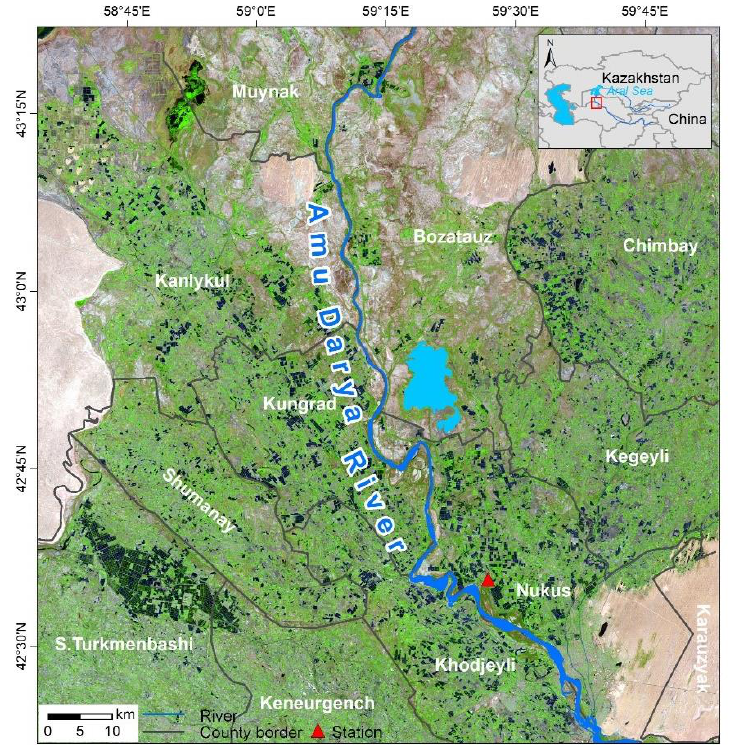
Figure 1. Location of the Amu Darya delta (ADD). Colour composite map of Landsat-8 OLI images in the ADD for 2019 in a colour combination of shortwave-infrared band 1, near-infrared and red band. Green represents vegetation, and brown represents bare